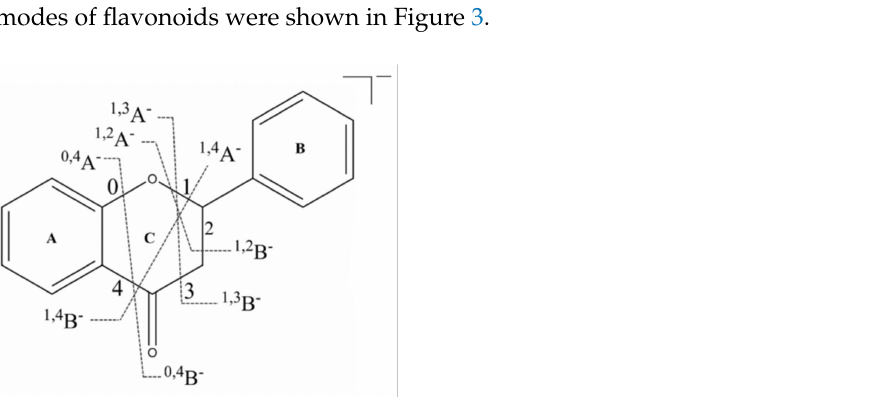
Figure 3. Schematic diagram of the fracture site of flavonoid aglycone in negative ion